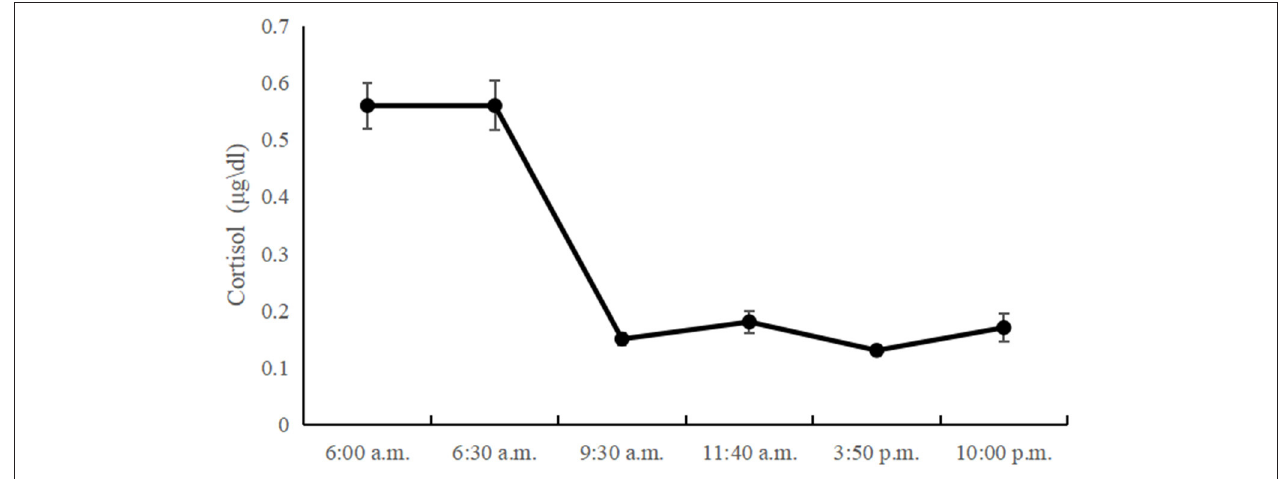
FIGURE 1 | The diurnal cortisol levels at all time-points in left-behind adolescents.